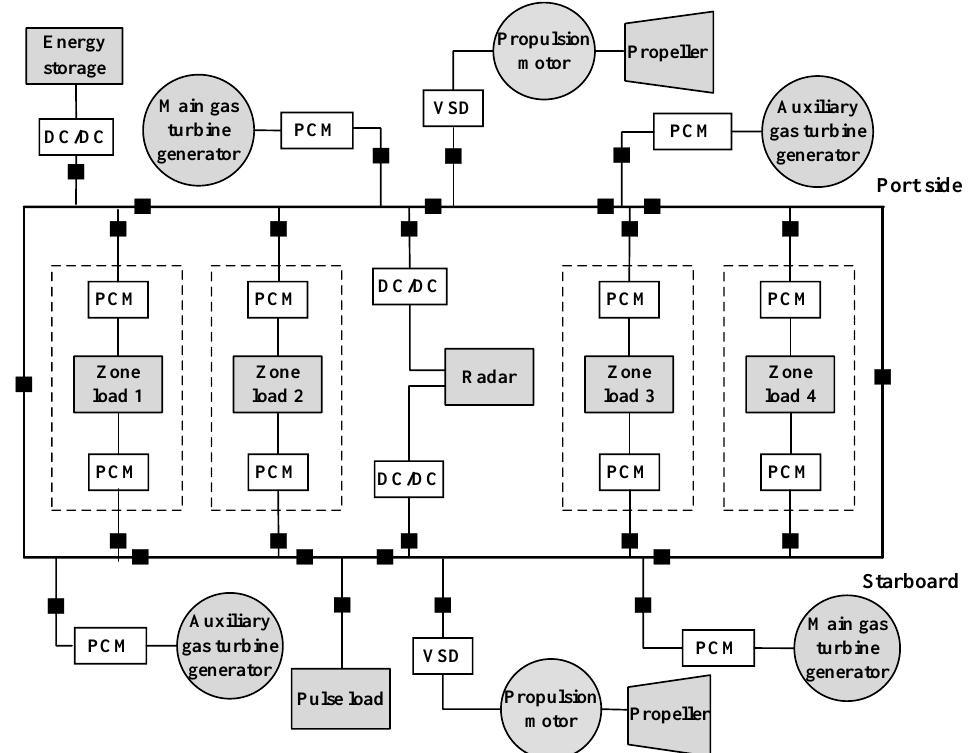
Figure 1. Topology structure of a shipboard medium-voltage DC integrated electric propulsion system (IEPS).